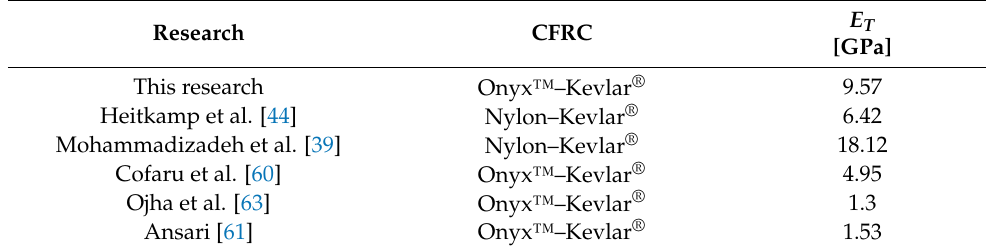
Table 4. Tensile modulus comparison with other CFRC research.